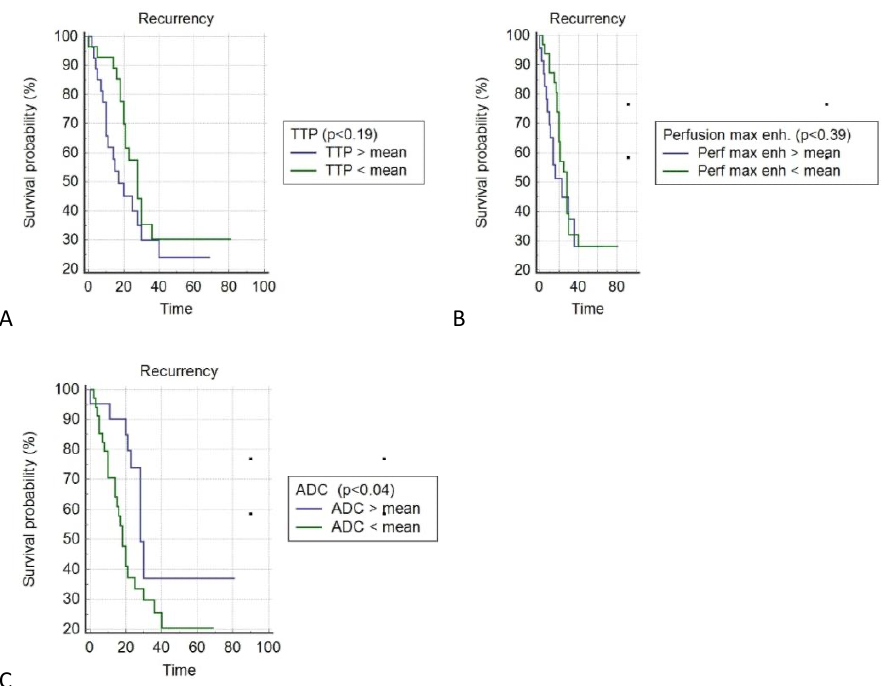
Figure 10. Inverse correlation between the values of Perf. Max. En. and PFS (months) in 34 patients who relapsed. Above: the distribution of Perf. Max. En. values; on the right: distribution of PFS (months).